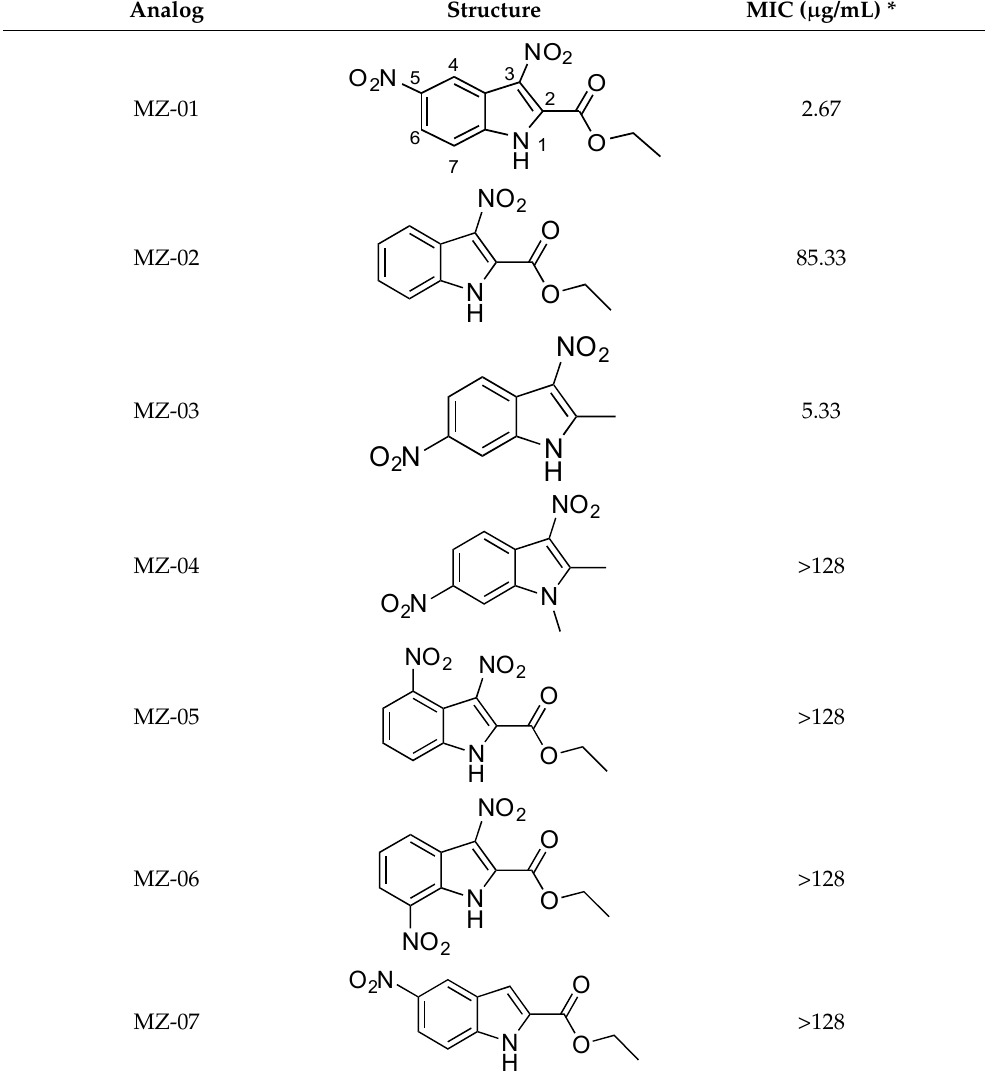
Table 2. Activity of MZ-01 analogs against MRSA WCUH29.